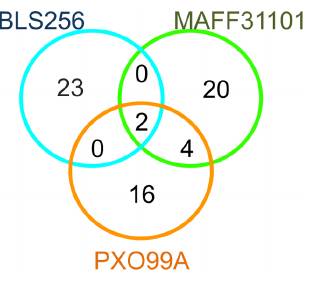
Figure 8. Overlap of candidate rice target gene sets for TALEs from various X.oryzae strains. Venn diagram of rice genes from the network assigned to distinct sets according to the strain of origin of their cognate